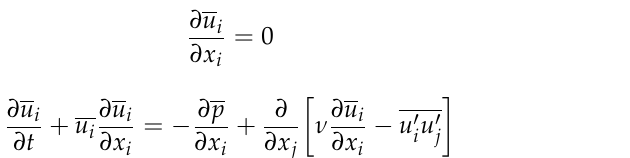
Table 1. Simulation cases for flow over two side ‐ by ‐ side cylinders. Re: Reynolds number.